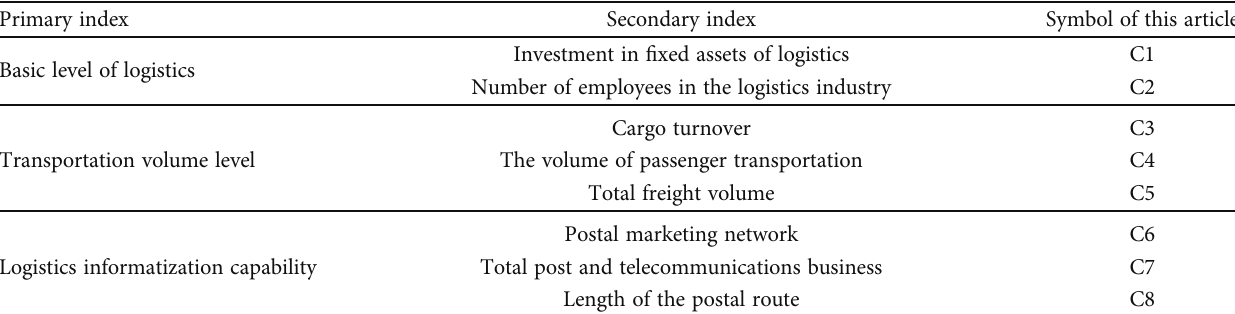
Table 3: Index system of urban logistics